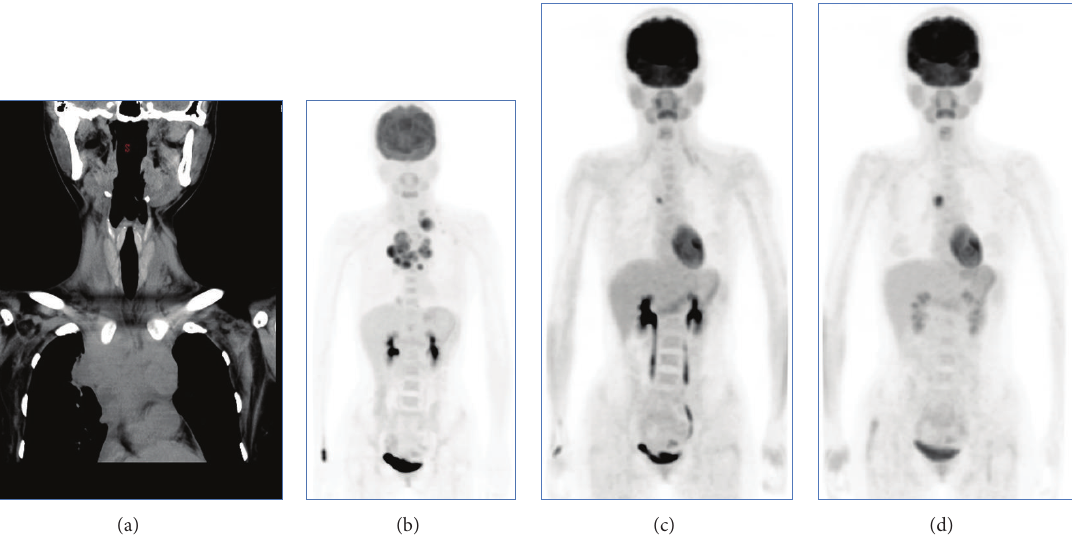
Figure 1: Images showing Hodgkin lymphoma refractory to induction chemotherapy. (a) Chest computerized tomography (CT) demonstrates the superior mediastinal tumor at diagnosis. (b) Positron emission tomography/computerized tomography (PET/CT) reveals involvement of right supraclavicular, left lower neck, mediastinal, epicardial, and retroperitoneal lymph nodes at initial diagnosis. (c) PET/CT after 4 cycles of induction chemotherapy shows partial remission with a residual uptake at right anterior mediastinum. (d) PET/CT after completion of 6 cycles of chemotherapy reveals relapse of the mediastinal